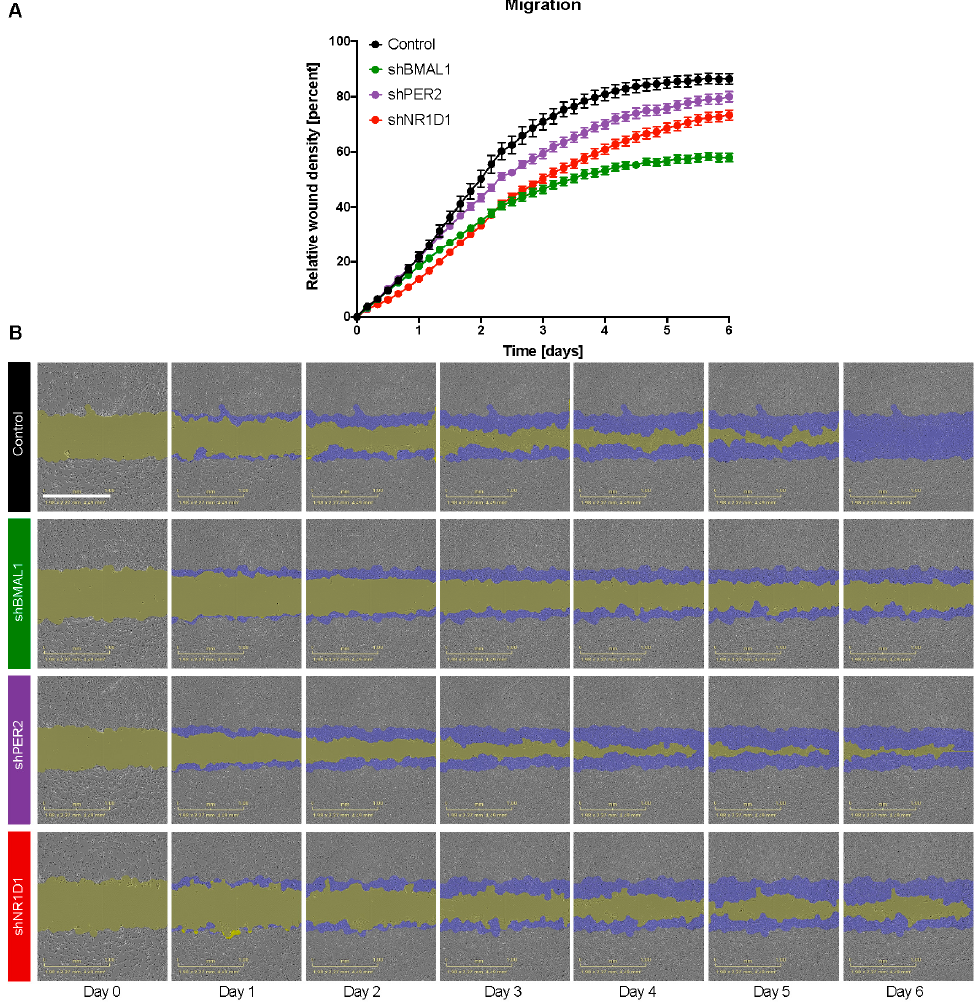
Figure 3. Core-clock gene knockdown affects cell migration in HCT116 cells. (A) Migration properties of control and shRNA KD HCT116 cell lines ( shBMAL1 , shPER2 and shNR1D1 ). Measurements were obtained using a scratch wound assay (IncuCyte). Quantification was performed by measuring the relative wound density over the course of 6 days ( n > 5, mean ± SEM, p < 0.05 for shBMAL1 , shPER2 and shNR1D1 compared to control, two-way ANOVA and corrected for multiple testing using Benjamini and Yekutieli method). ( B ) Representation of the scratch wound assay using the IncuCyte S3 software over the course of 6 days. Blue mask indicates the initial scratch wound area. Gold mask indicates wound border area (cell-free area). Scale bar: 1mm.